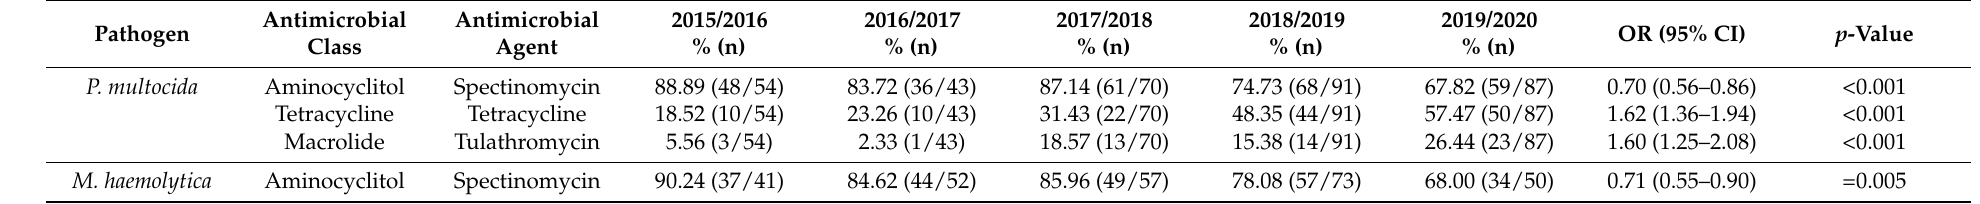
Table 3. Statistically significant trends, decrease or increase, regarding the not susceptibility of bacterial pathogens investigated in this study over the five-year period 2015–2020 in Bavaria,